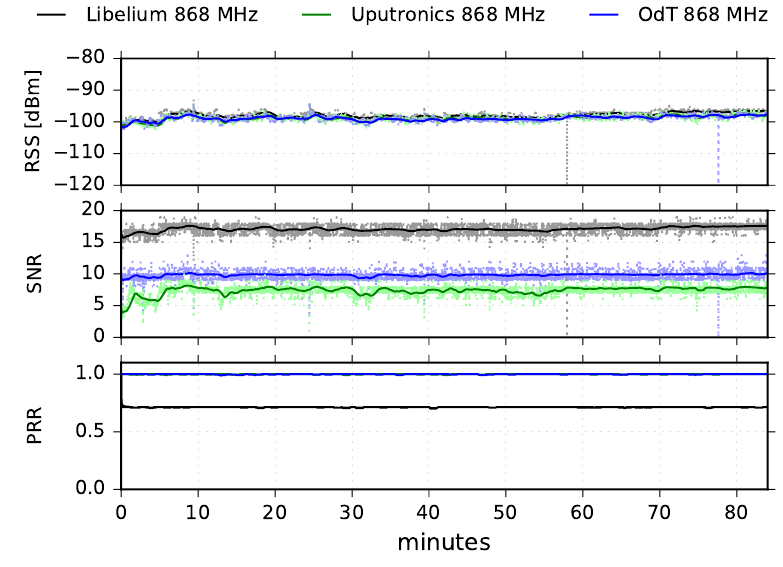
Figure 9. RSS, SNR, and PRR for ODT, Libelium, and Uputronics at 868MHz in LOS trajectory for BW = 125kHz, SF = 7 and CR =